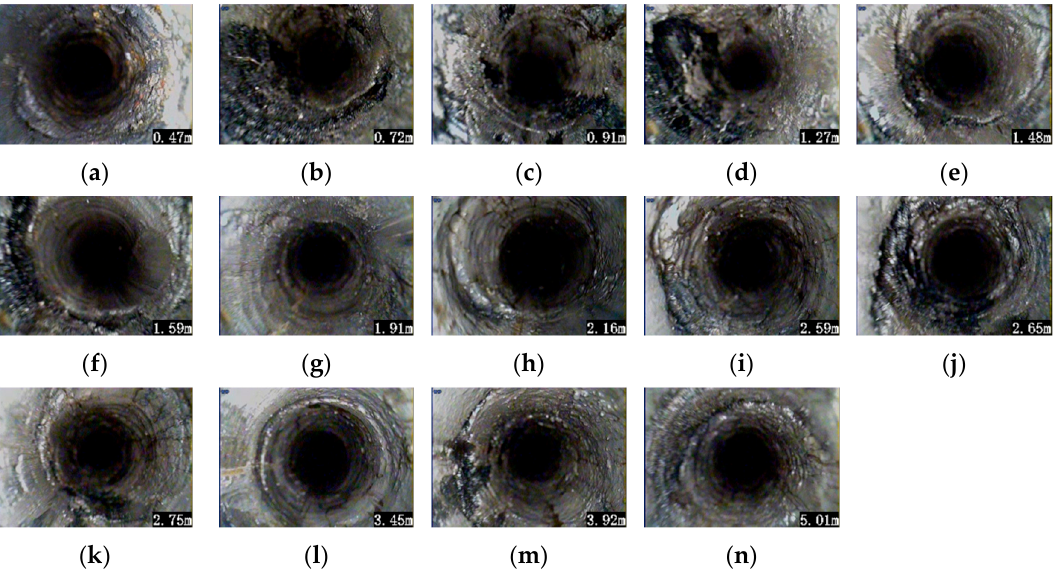
Figure 13. Borehole observation under the original support. ( a ) 0.47 m; ( b ) 0.72 m; ( c ) 0.91 m; ( d ) 1.27 m; ( e ) 1.48 m; ( f ) 1.59 m; ( g ) 1.91 m; ( h ) 2.16 m. ( i ) 2.59 m; ( j ) 2.65 m; ( k ) 2.75 m; ( l ) 3.45 m. ( m ) 3.92 m; ( n ) 5.01